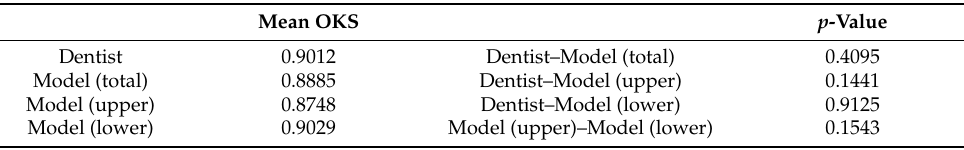
Table 2. Mean object keypoint similarity (OKS) values of a dentist and the model.